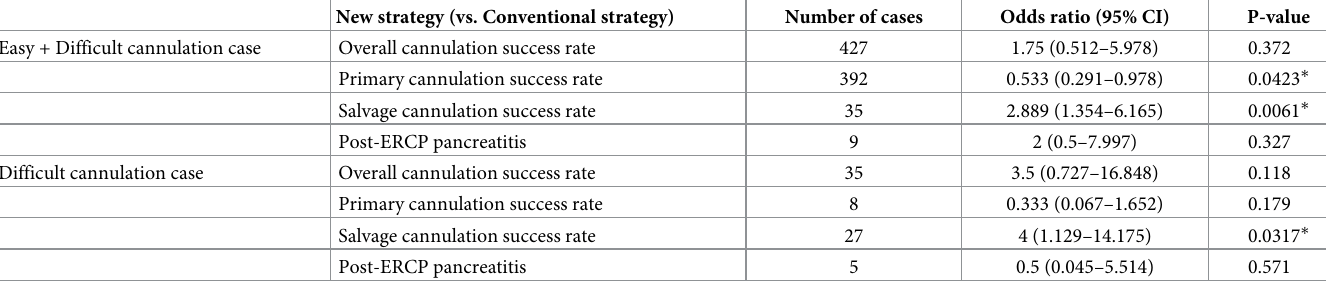
Table 4. Odds ratios for cannulation success rate and post-ERCP between the new strategy and the conventional strategy. New strategy (vs. Conventional